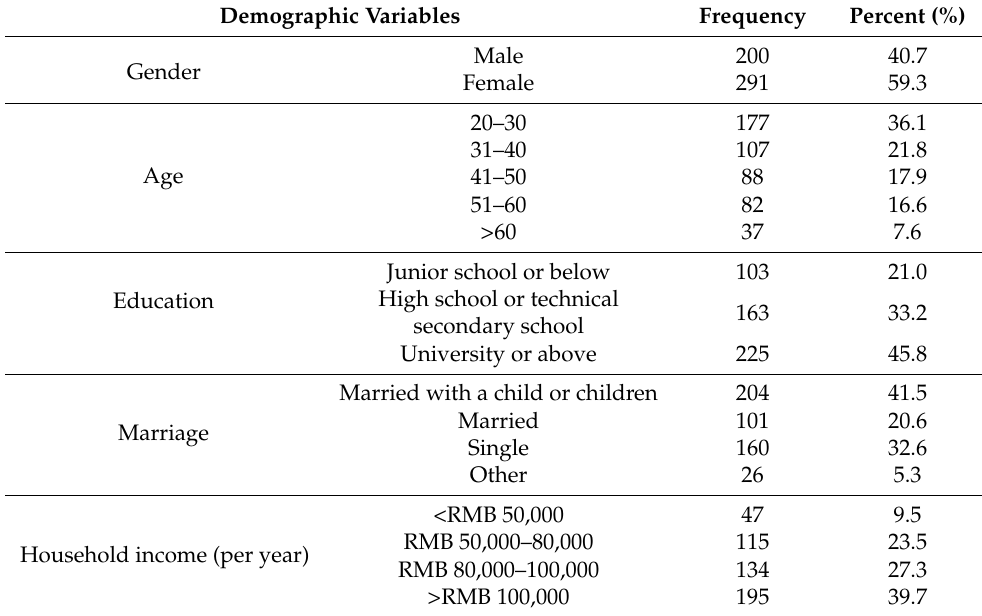
Table 3. Demographic characteristics of the samples ( n = 491).